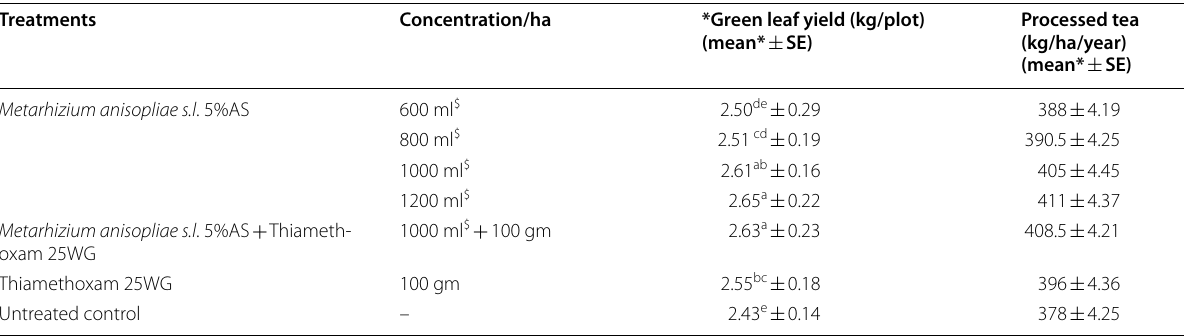
Table 2 Effect of Metarhizium anisopliae 5% AS on tea yield